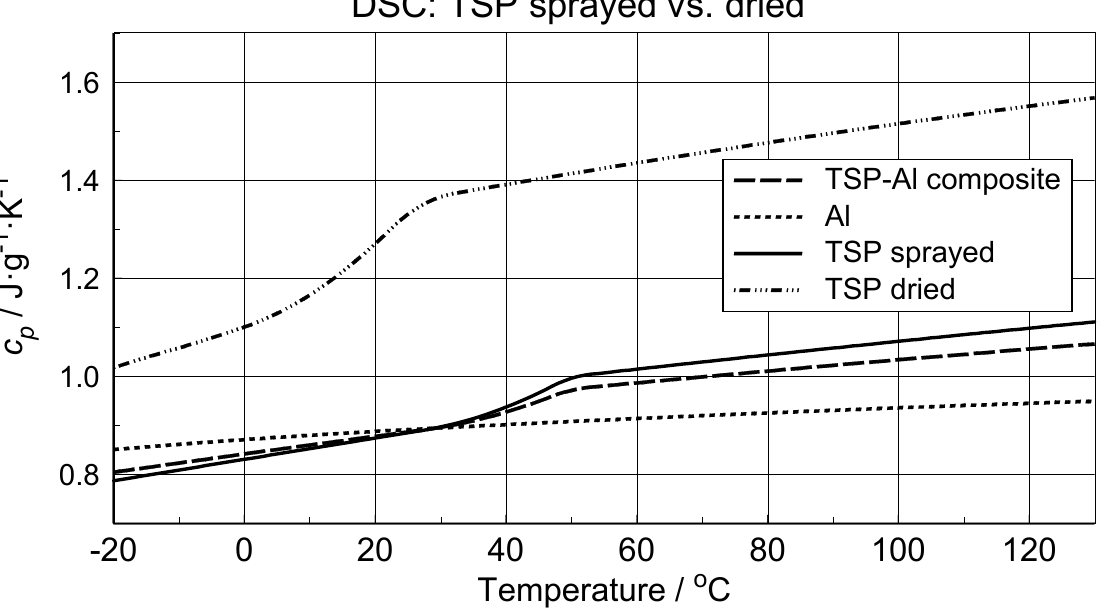
Figure 6. Direct results, not corrected for mass changes, of microcalorimetric investigation of TSP deposited by aerosol spraying on the aluminum foil substrate—the effective heat capacity in function of the temperature.